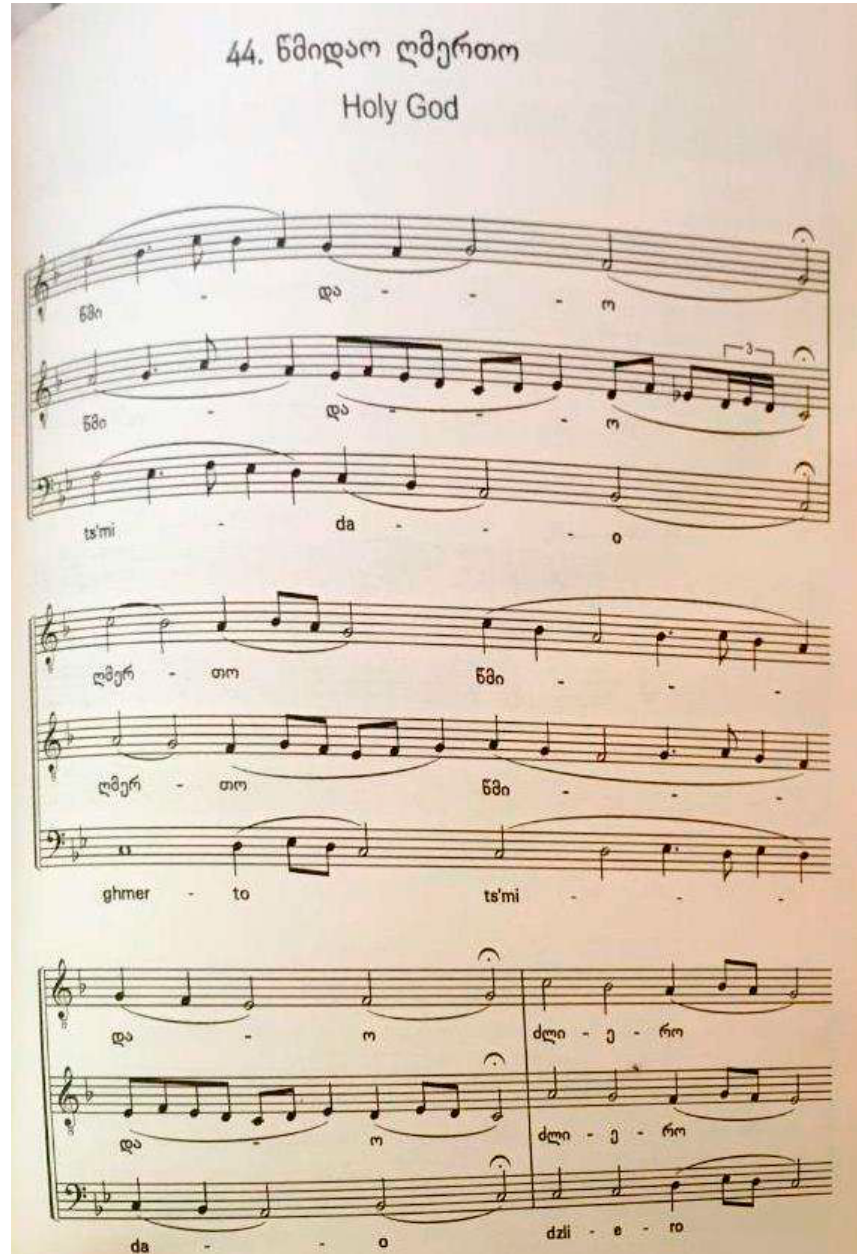
Figure 9. Trisagion; Svetitskhoveli School (Shugliashvili and Tsereteli 2012).